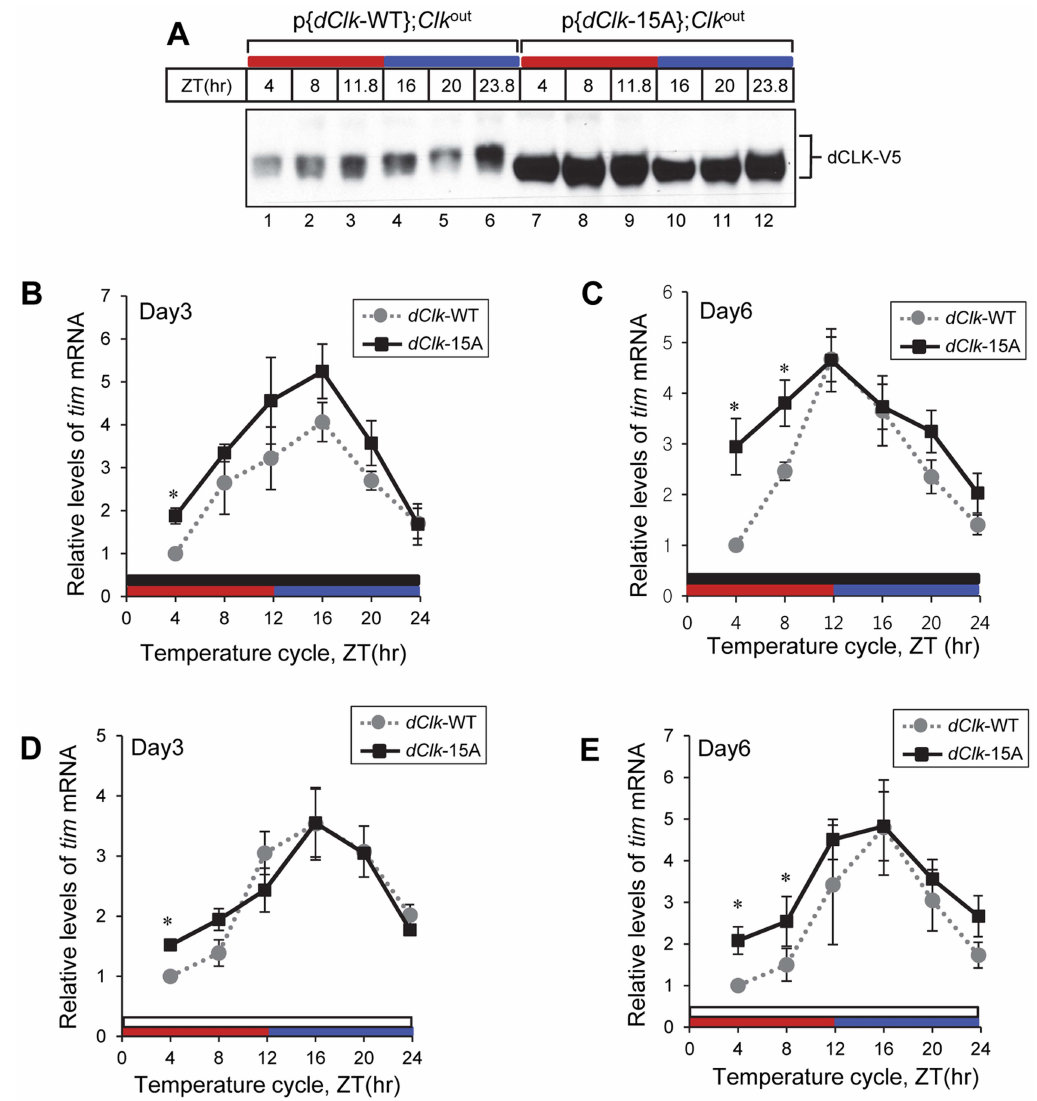
Figure 6. Molecular rhythms in p{ dClk -15A}; Clk out flies show increased alterations after prolonged entrainment to temperature cycles. Adult flies of the indicated genotype were entrained in 12 hr:12 hr of 24 u C:29 u C temperature cycle in the absence (A–C) or presence of light (D, E). During the third (A, B, D) and sixth day (C, E) of TC, flies were collected and protein (A) or RNA (B–E) was extracted from fly heads. Protein extracts were analyzed by immunoblotting using anti-V5 Ab to probe dCLK. Quantitative real-time RT-PCR was performed to measure the relative levels of tim mRNA. Shown are the average values from three independent experiments using p{ dClk -15A}, 6M; Clk out flies. *p , 0.05; error bars denote SEM. Red horizontal bars represent thermo phase, blue horizontal bars represent cryo phase, black horizontal bars represents constant dark conditions, and white horizontal bars represents constant light conditions.